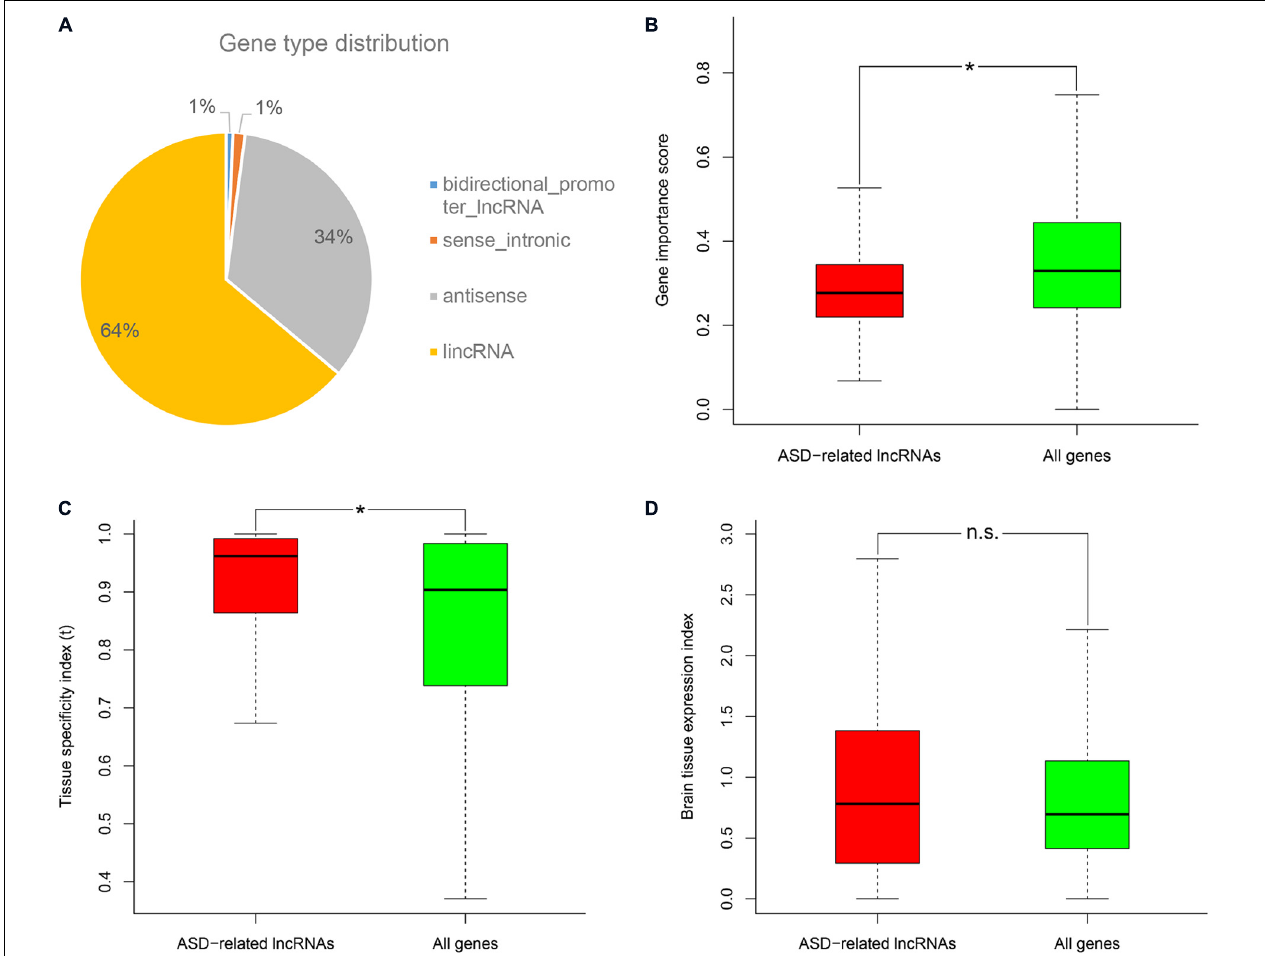
FIGURE 1 | Gene type distribution and characteristics analysis of ASD-related lncRNAs. (A) Pie chart displays the distribution of ASD-related lncRNAs in different gene types. Comparison of ASD-related lncRNAs with the background genes in the (B) gene importance score, (C) tissue specificity index τ , and (D) brain tissue expression index. * P -value < 10E-5 from Wilcoxon test. N.s. represents no statistical